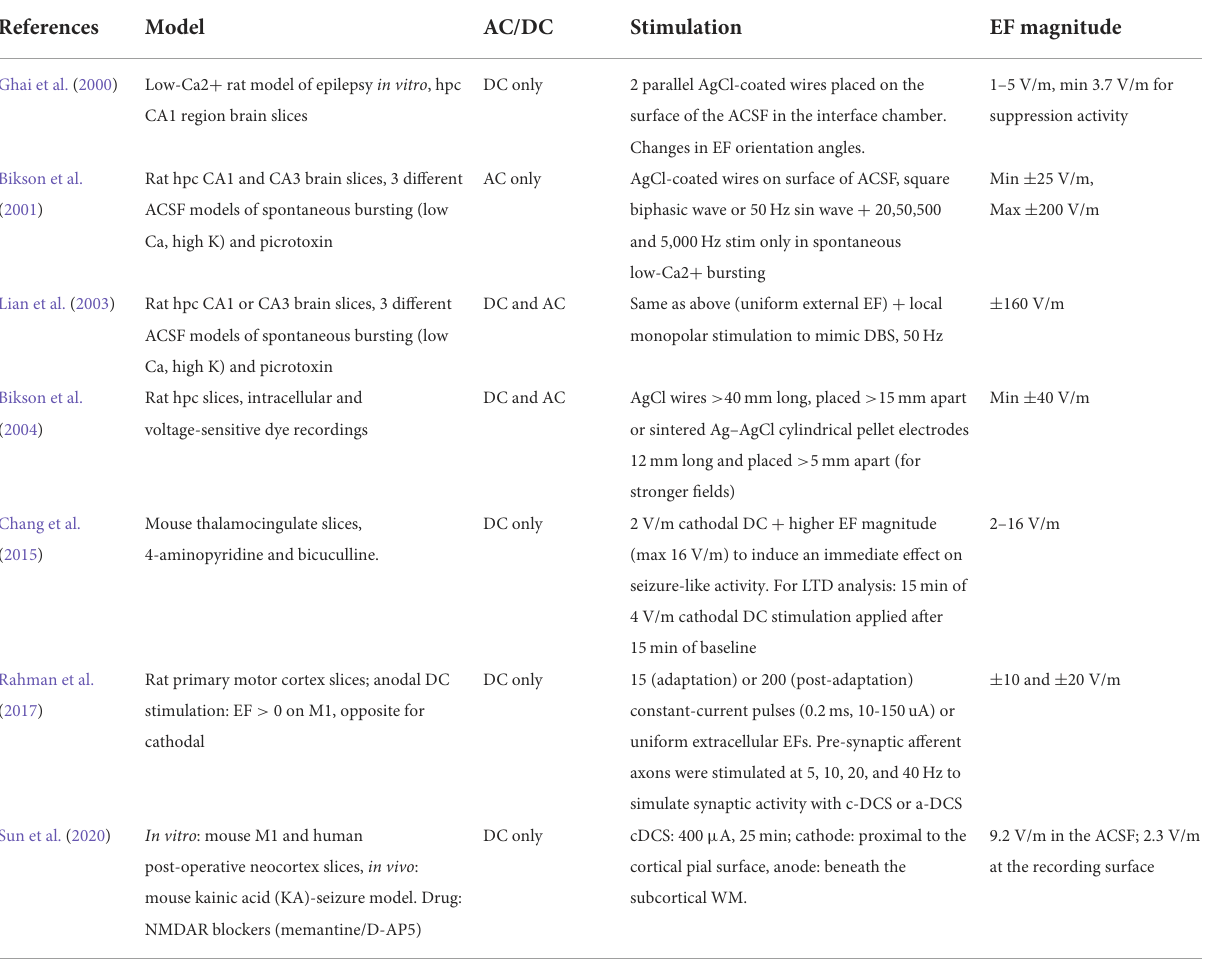
TABLE 3 Models and stimulation methods used in in vitro